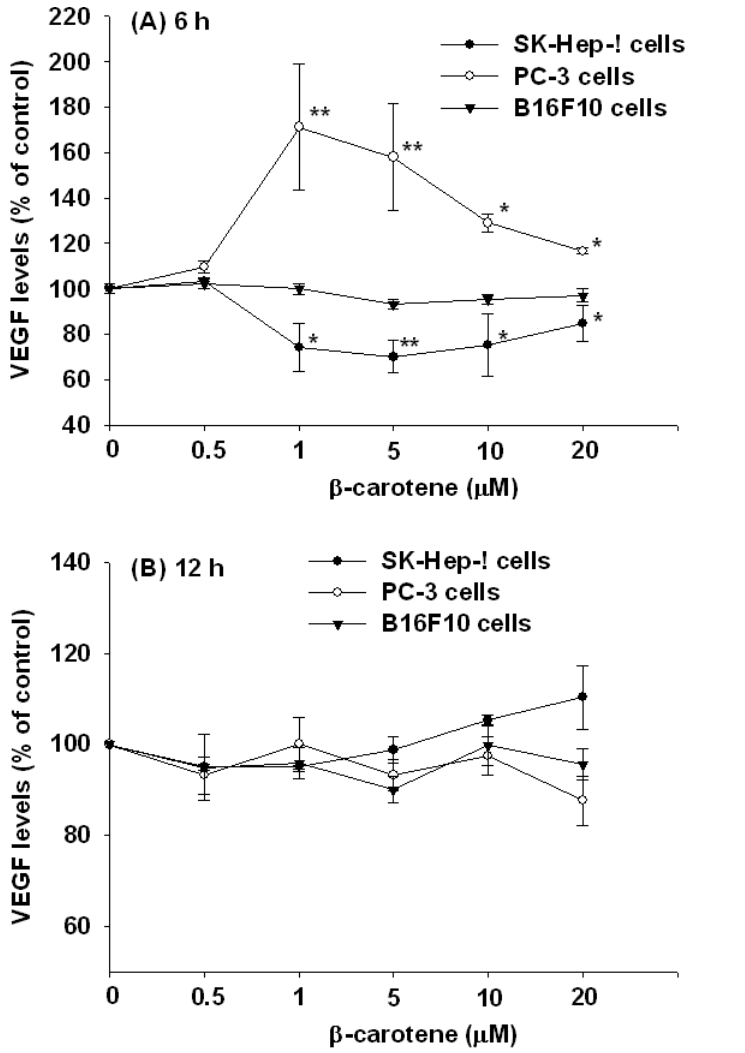
Figure 1. Effect of β -carotene (BC) on VEGF secretion in SK-Hep-1, PC-3 and B16F10 cells. Cells were incubated with BC (0–20 μ M) for 6 and 12 h. ( A ) 6 h; ( B ) 12 h. Data (means ± SD) are from three or four separate experiments; * P < 0.05; ** P < 0.01 compared to control (0 μ M β